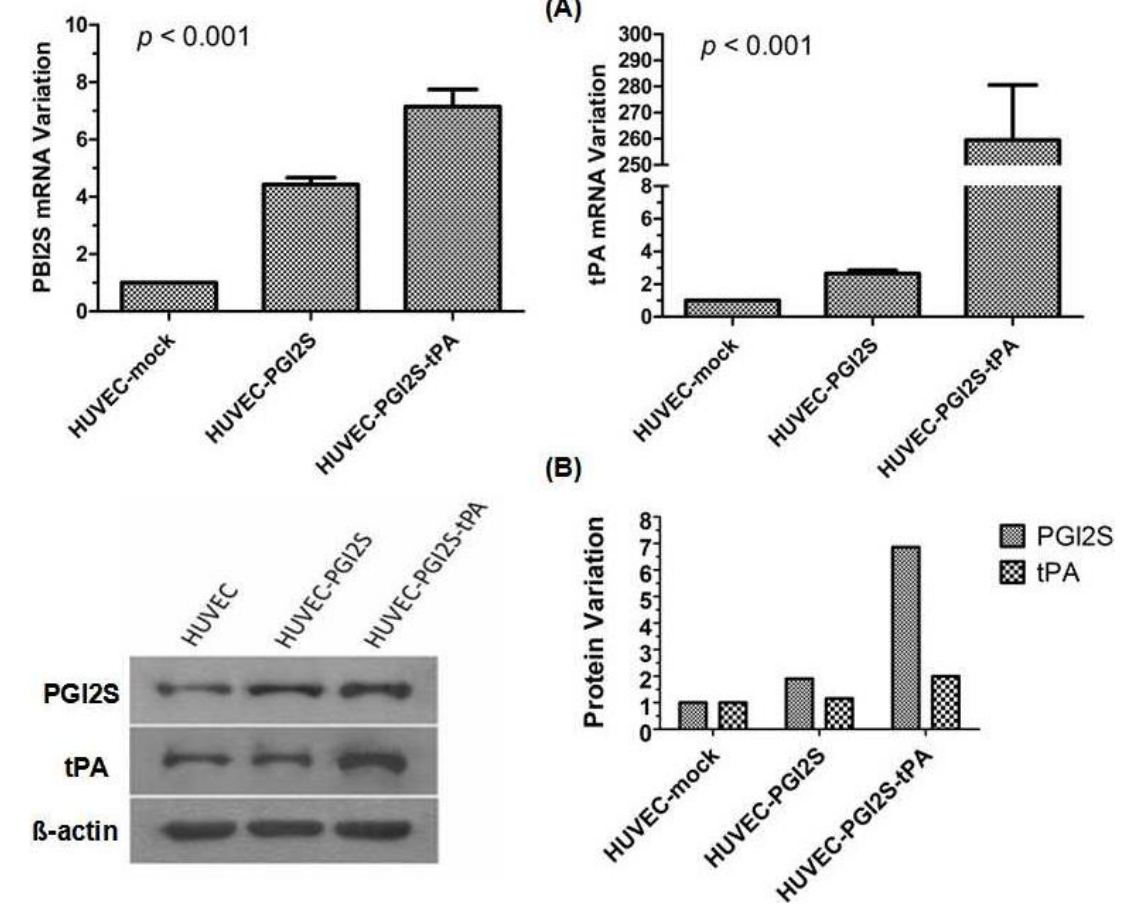
Figure 1. Expression of PGI2S and tPA in HUVEC-mock, HUVEC- PGI2S , and HUVEC- PGI2S-tPA cell lines. ( A ) PGI2S and tPA mRNA expression were analyzed by quantitative real-time PCR and expressed relative to the HUVEC-mock cell line. Values are means ± S.D. of triplicates. p values were calculated using one-way ANOVA; ( B ) Analysis of PGI2S and tPA protein expression by Western blotting in HUVEC-mock, HUVEC- PGI2S , and HUVEC- PGI2S-tPA cell lines. The Western blotting analyses were performed in